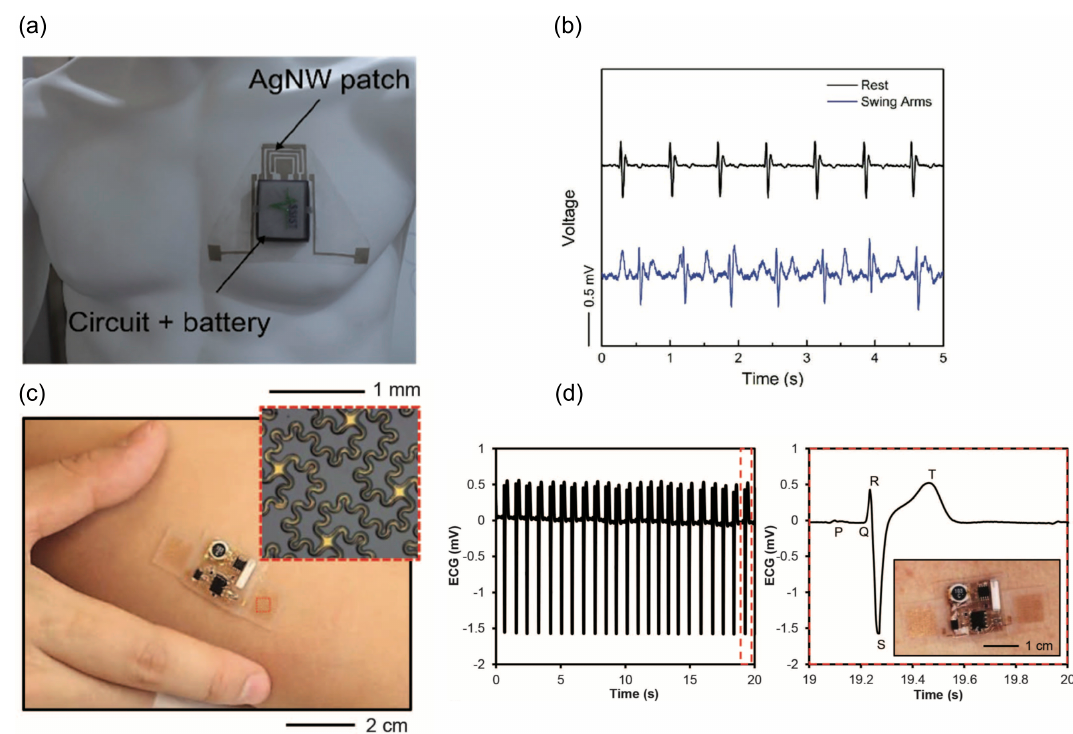
Figure 3. Wearable electrocardiography (ECG) monitoring devices: ( a ) integrated chest patch for ECG and skin impedance monitoring by electrodes made from AgNW encapsulated in PDMS (Polydimethylsiloxane); and ( b ) recorded ECG in resting and swinging arms conditions (Reprinted with permission [11]. Copyright 2017, John Wiley and Sons); ( c ) Flexible and stretchable ECG sensing device attached to forearm; and ( d ) acquired ECG by placing the device on sternum (Reprinted with permission [12]. Copyright 2014, The American Association for the Advancement of Science).